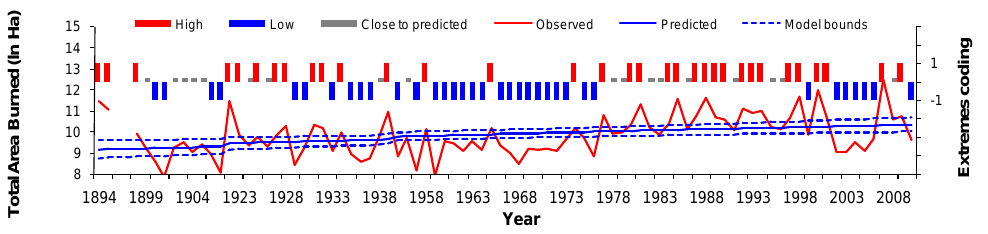
Fig. 3. Trend lines and the 95% confidence intervals of the trend line of fire occurrence statistics (burned area). These are used as bounds to define strongly positive (red columns), strongly negative (blue columns) and close-to-predicted (grey columns) values of fire occurrence.